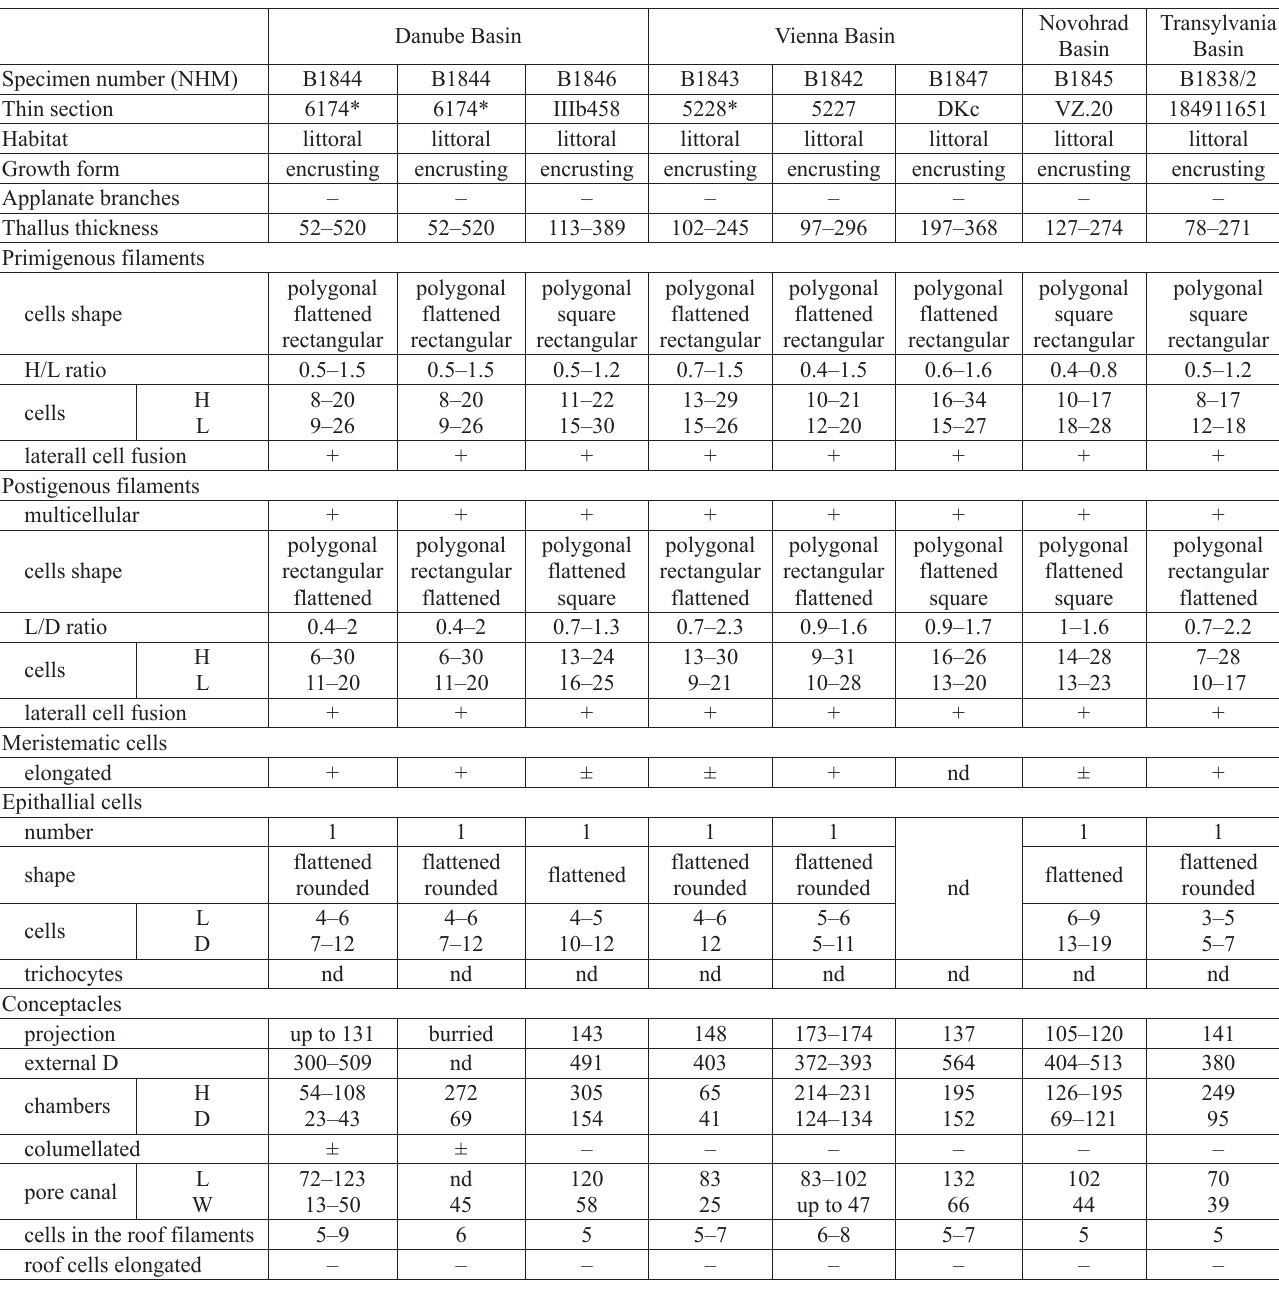
Table 5. Comparative table of selected Hydrolithon lemoinei (Miranda, 1935) Aguirre, Braga, and Bassi, 2011 specimens. * marks gametangial or carpogonial-carposporangial plants. Abbreviations: D, diameter; H, height; L, length; W, wide; nd, no data; “+” presence and “–” absence of character; “±” intermediate. All measurements in μ